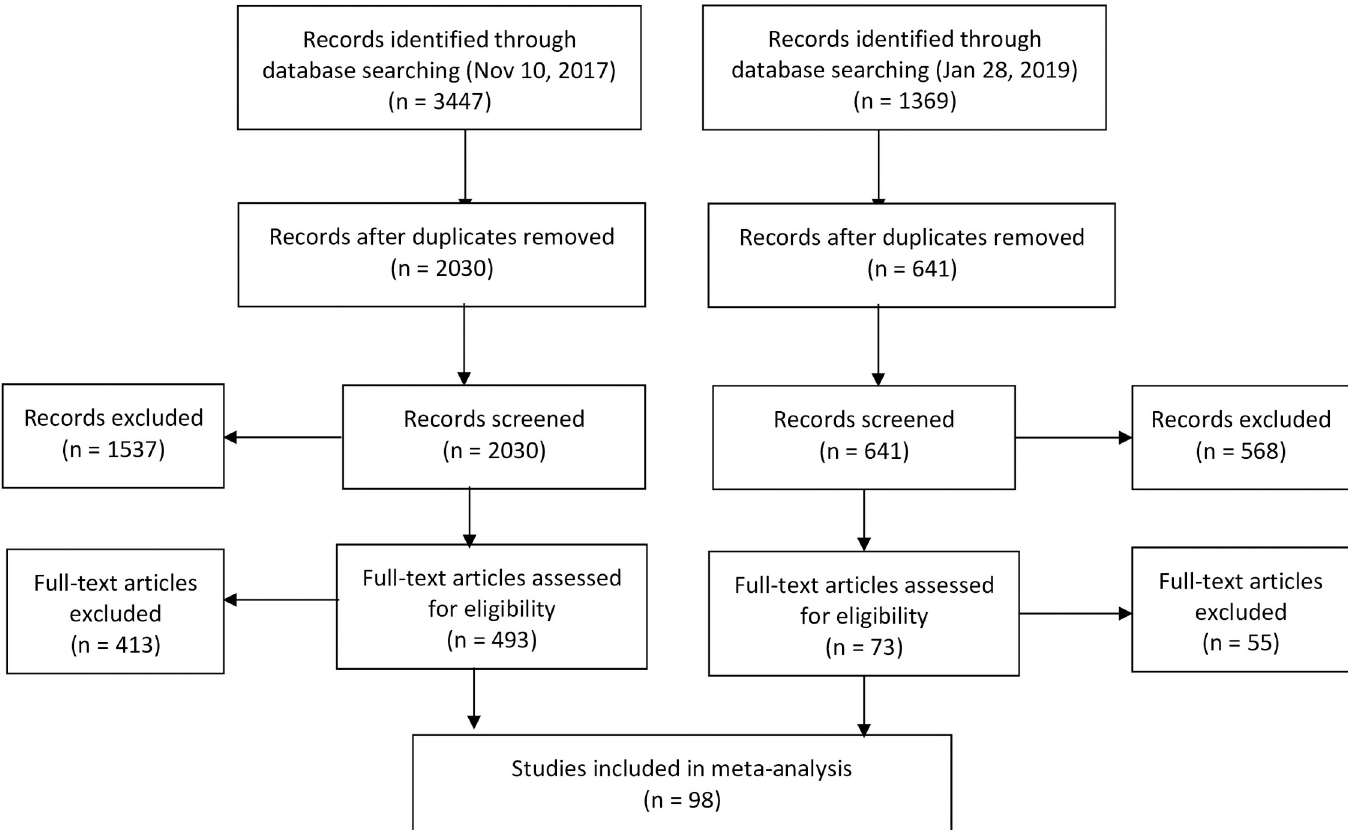
Fig 1. PRISMA flow chart describing the study selection